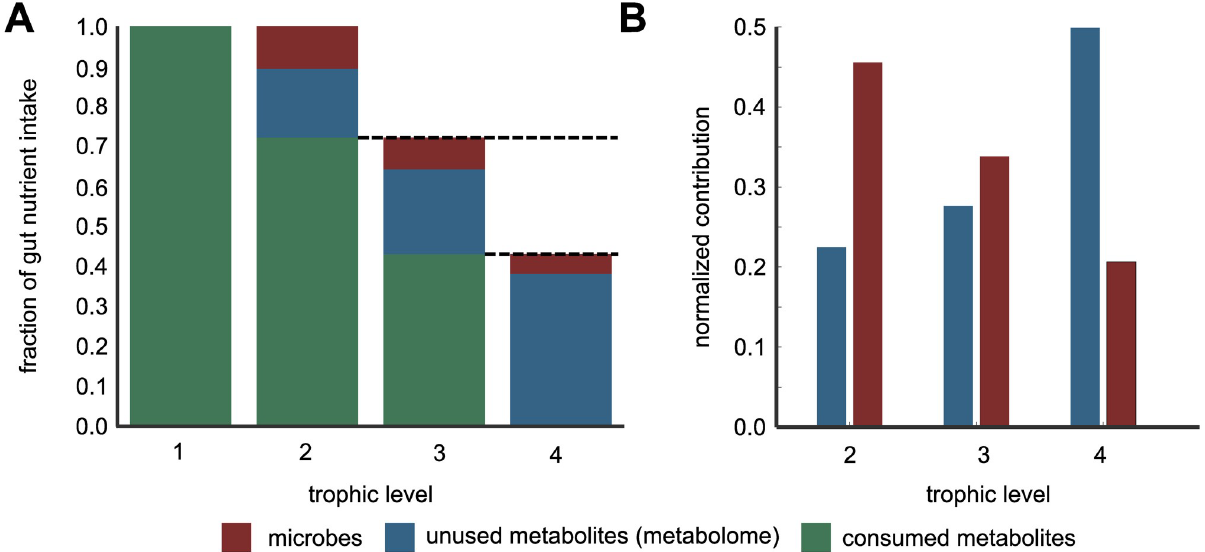
Fig 3. Metabolite and biomass flow through the levels. (A) Cascading nature of nutrient flow across trophic levels: nutrient intake to the gut (the leftmost turquoise bar) is gradually converted into microbial biomass (red bars in each level) and metabolic byproducts (turquoise bars in each level). Some fraction of these byproducts (blue bars in each level) cannot be consumed by the microbiome and hence remains further unprocessed until it leaves an individual as their fecal metabolome. The metabolic byproducts of each level (turquoise bars) serve as the nutrient intake for microbes in the next level. The process ends at level 4 where all byproducts remain unconsumed thereby enter the fecal metabolome. (B) Normalized contribution of of the nutrient intake to microbial biomass (red) and fecal metabolome (blue) split across levels 2 to 4. Dashed lines show that consumable metabolites generated at a previous level serve as metabolic inputs to the next